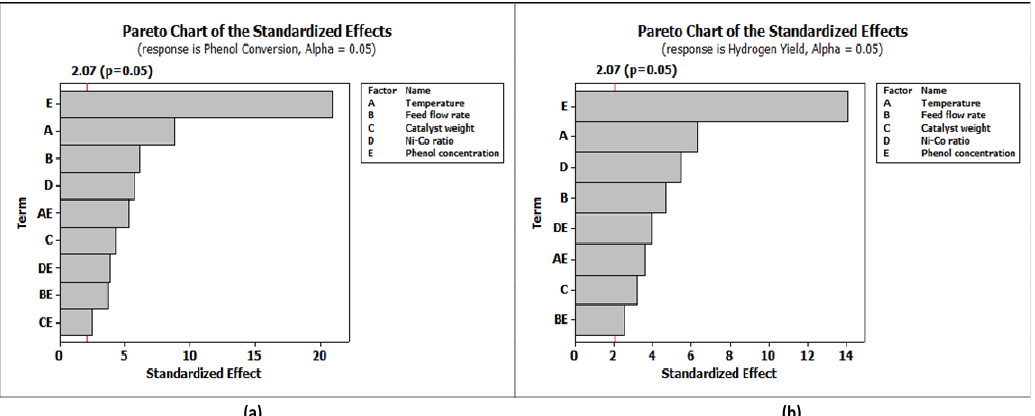
Figure 7. Pareto chart of the reduced model for ( a ) Y 1 and ( b ) Y 2 .